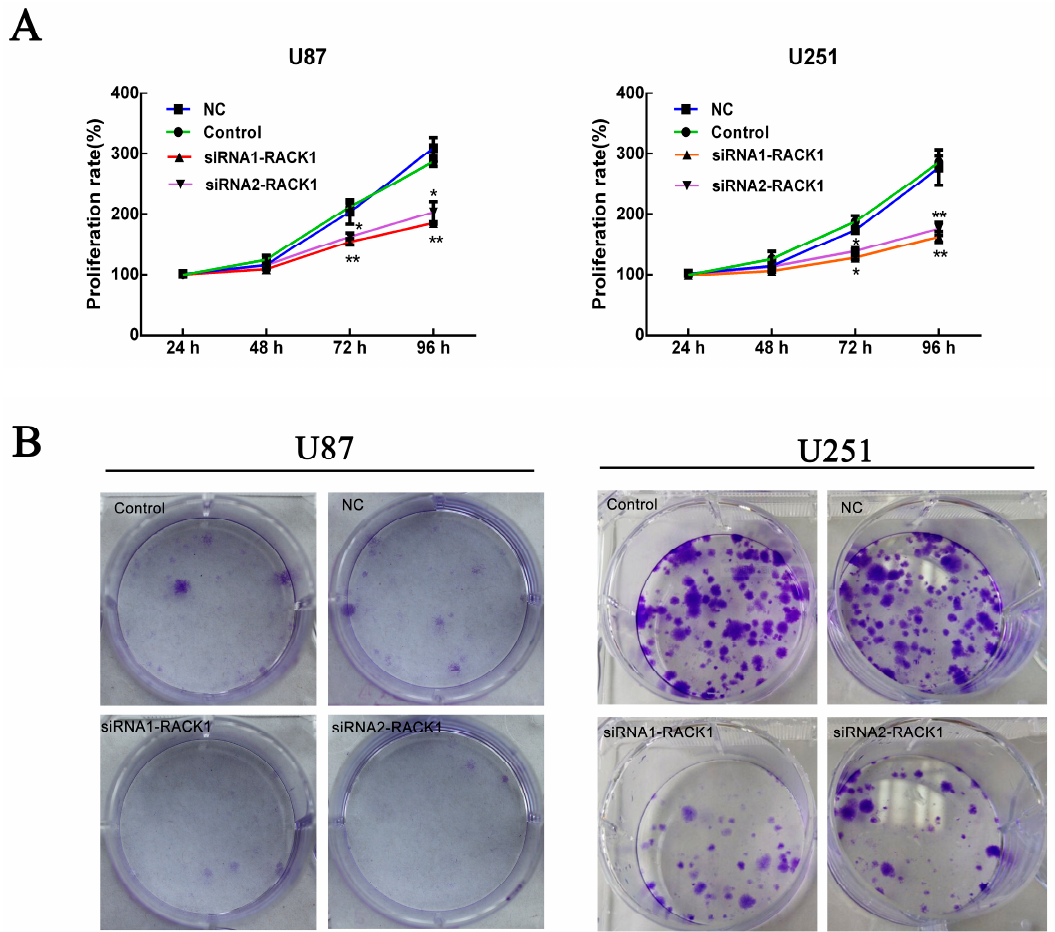
Figure 3. Knockdown of RACK1 suppressed the proliferation of U87 and U251 cells. ( A ) CellTiter 96 aqueous one solution reagent (MTS) assay demonstrated that the proliferation activities of the U87 and U251 cells were significantly inhibited by siRNA1-RACK1 and siRNA2-RACK1 at 96 h after transfection (** p < 0.01, * p < 0.05 for U87, ** p < 0.01, ** p < 0.01 for U251); ( B ) Colony formation assay indicated that silencing of RACK1 significantly decreased the number of colonies of the U87 and U251 cells in comparison with NC groups.